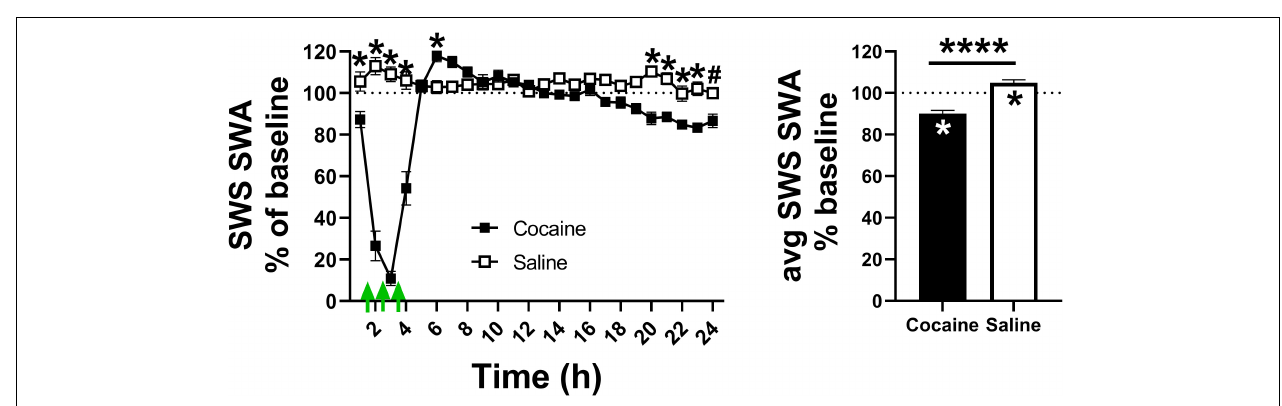
FIGURE 5 | (Left) Cocaine exposure decreased sleep intensity, as measured by SWS SWA, during the hours in which cocaine was administered (indicated by the green arrows) after which sleep intensity briefly rebounded then ended below saline. (Right) Cocaine induced a net decrease in average SWS SWA compared to saline and baseline levels while saline induced a net increase in SWS SWA compared to baseline levels. Cocaine n = 10, saline n = 9. The dashed line at 100 indicates baseline level, the asterisks above the symbols or lines indicate a between group difference at those timepoints, the asterisks within bars indicate a within-group difference from baseline. P and F values are given in Table 1 and statistics for all pairwise comparisons with significant difference or trends toward significance are given in Supplementary Table 3